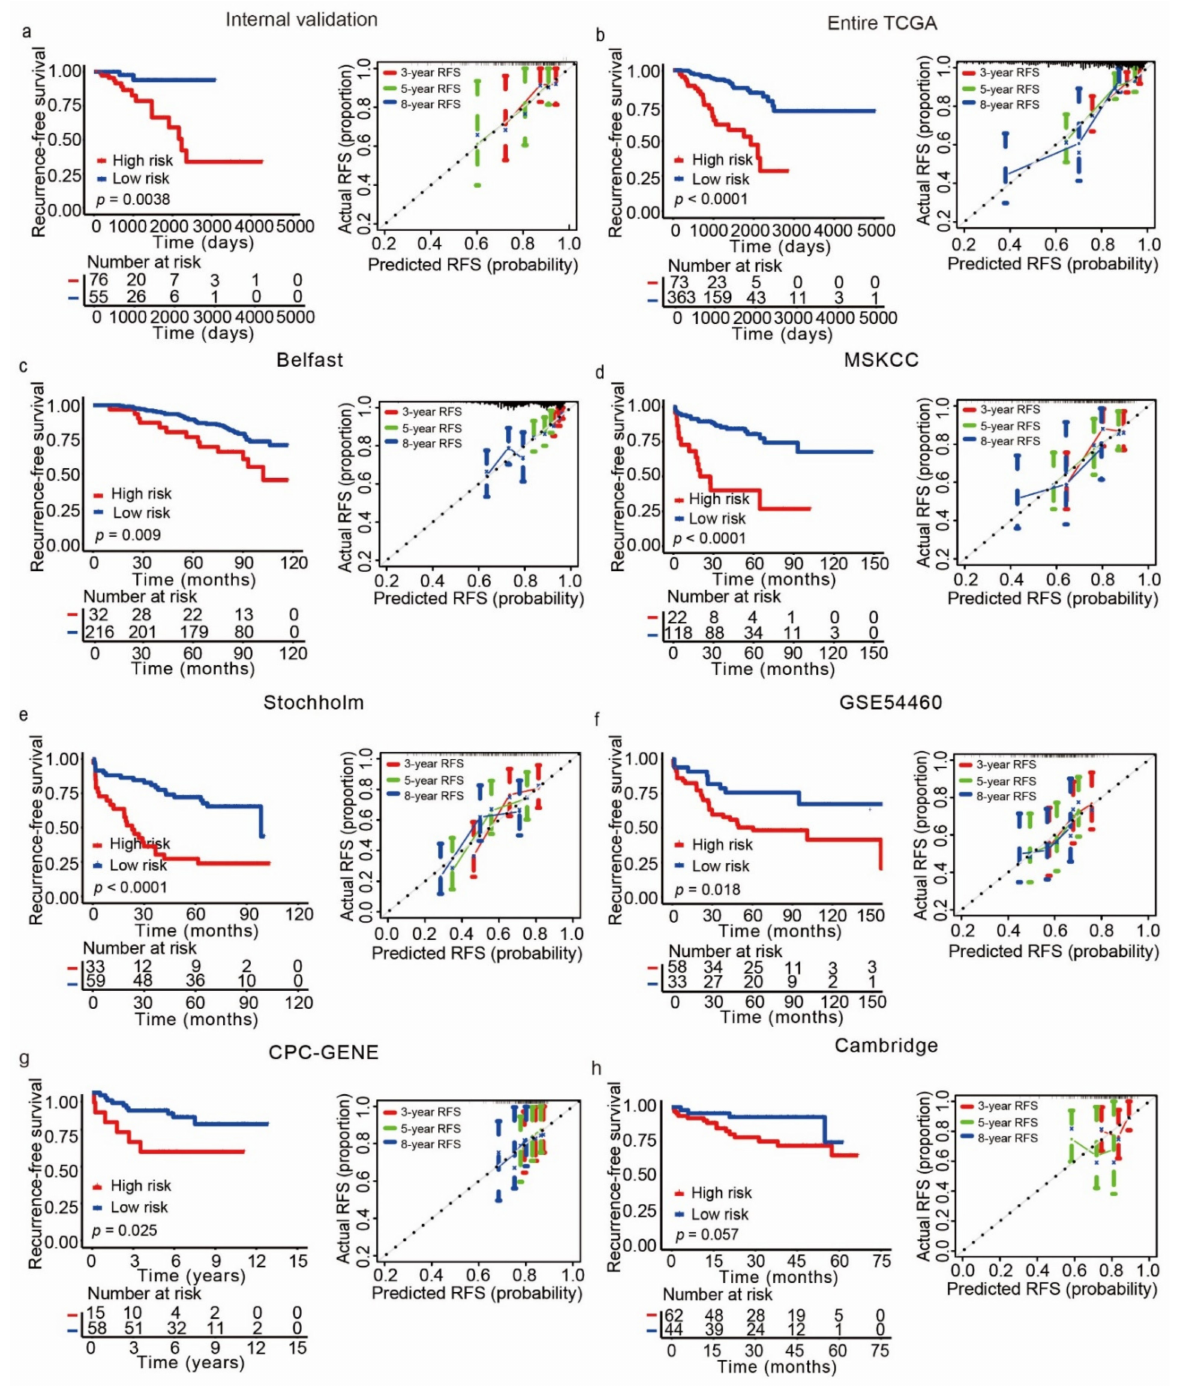
Figure 6. Performance of the CRPCPS in different validation cohorts. Kaplan–Meier plots were used to visualize the RFS probabilities for the high-risk versus low-risk patients (left panel). The calibration curves were applied to evaluate 3-, 5-, and 8-year RFS probabilities (right panel) in the internal validation cohort ( a ), the Entire TCGA cohort ( b ), the Belfast cohort (GSE116918) ( c ), the MSKCC cohort ( d ), the Stockholm cohort (GSE70769) ( e ), the GSE54460 cohort ( f ), the CPC-GENE cohort ( g ), and the Cambridge cohort (GSE70768) ( h